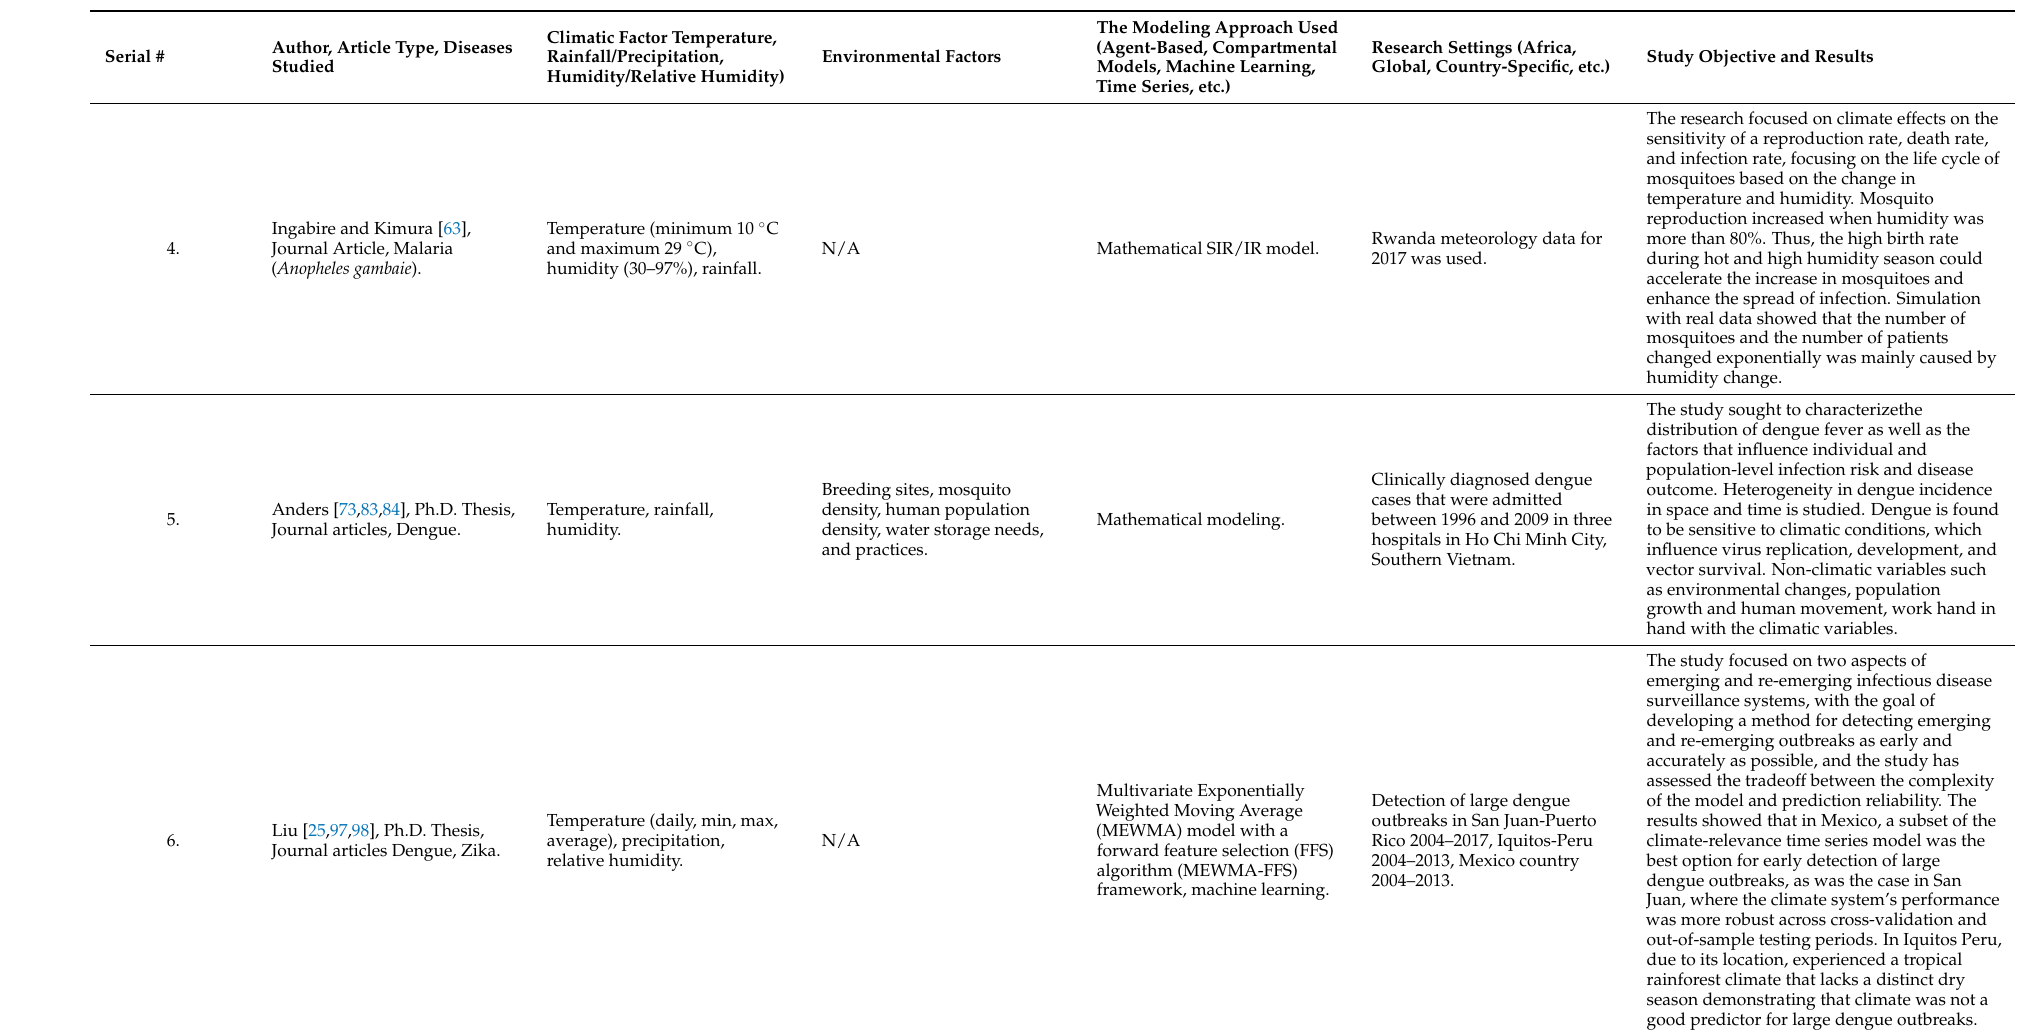
algorithm (MEWMA-FFS) framework, machine